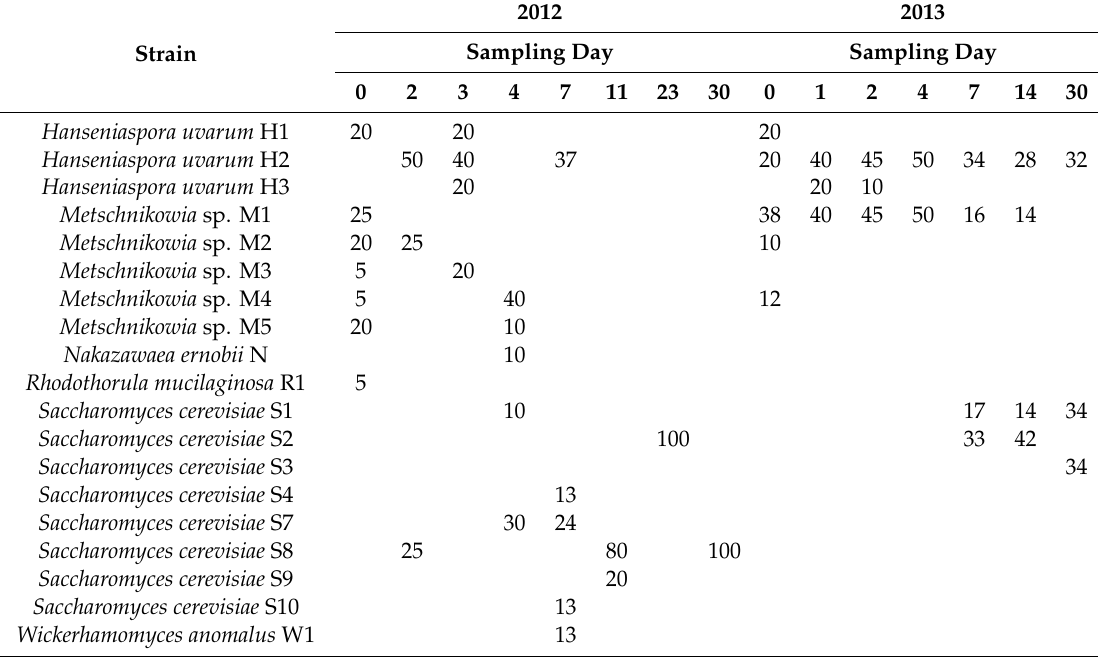
Table5. Yeaststrains(%)isolatedfromdi ff erentstagesofW˛egierkaD ˛abrowickaplummashfermentation (2012 and 2013 seasons).